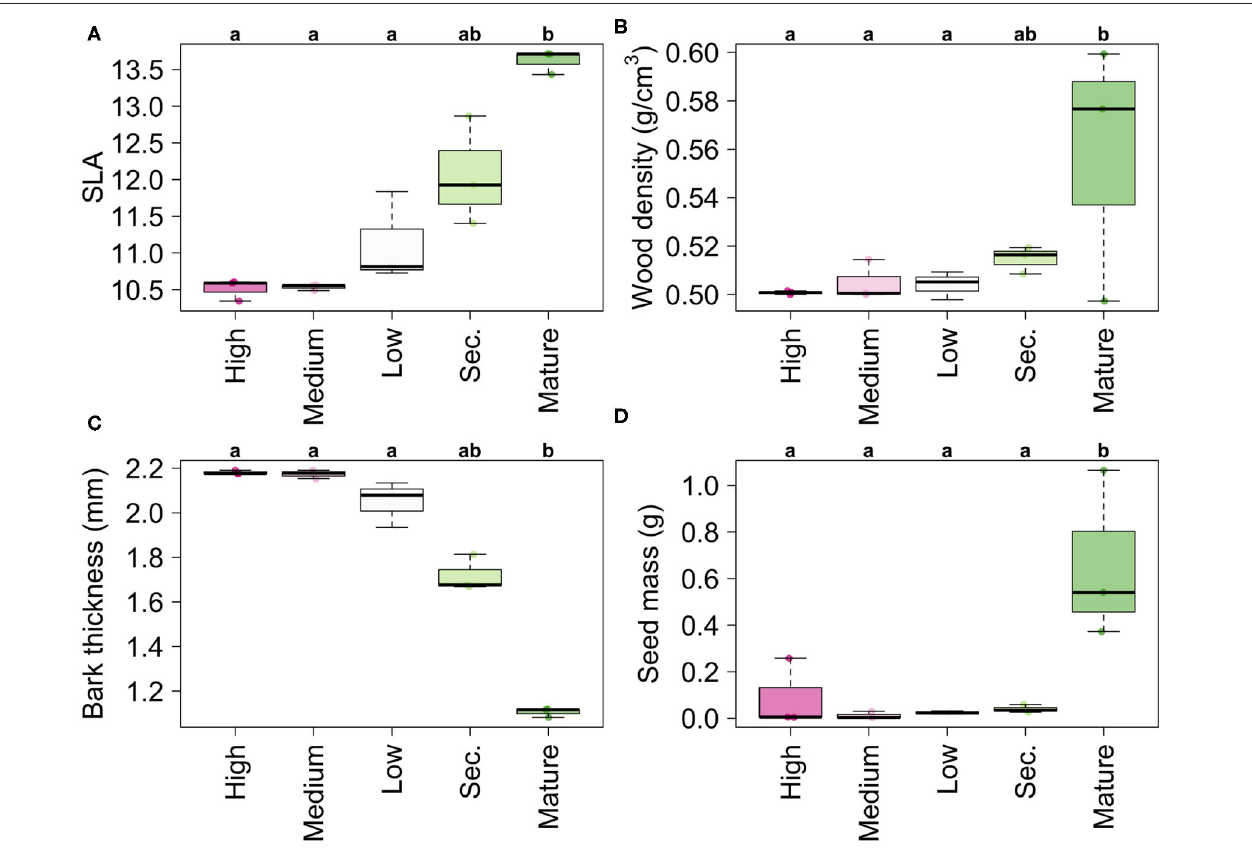
FIGURE 4 | Community-weighted values for the following functional traits: (A) Specific Leaf Area, (B) Wood density, (C) Bark thickness, (D) Seed mass along the disturbance gradient, from areas with high disturbance frequency to Mature Forests. Letters indicate significance groups ( α = 0.05) following a permutation-based pairwise comparison. The statistics for these comparisons are in Supplementary Material (Basso et al.,